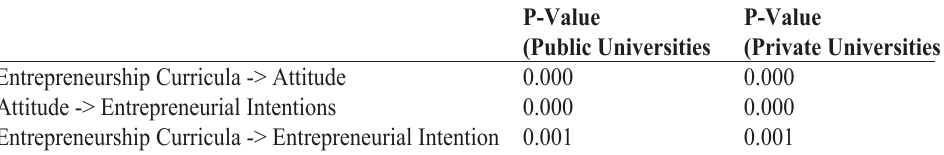
Comparison Based on